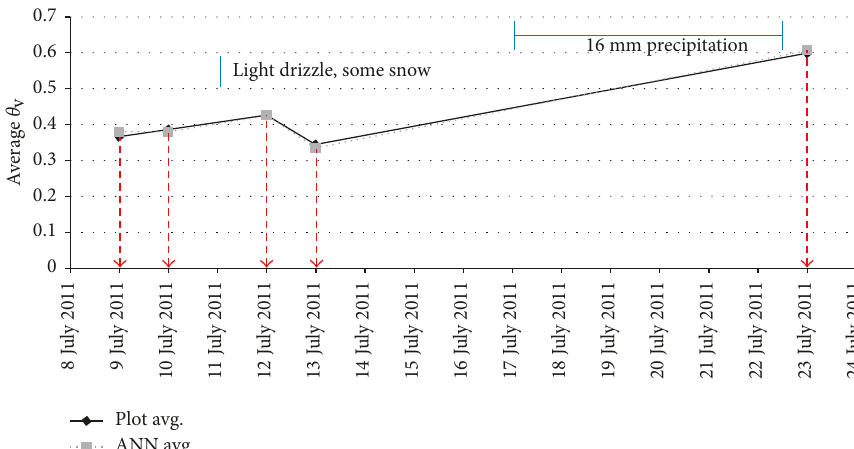
Figure 13: Comparison of field-measured average soil moisture to ANN-modelled average soil moisture. Values are within 0.015 θ other for each date. Arrows indicate RADARSAT-2 data acquisition dates. Timing and duration of precipitation events are also